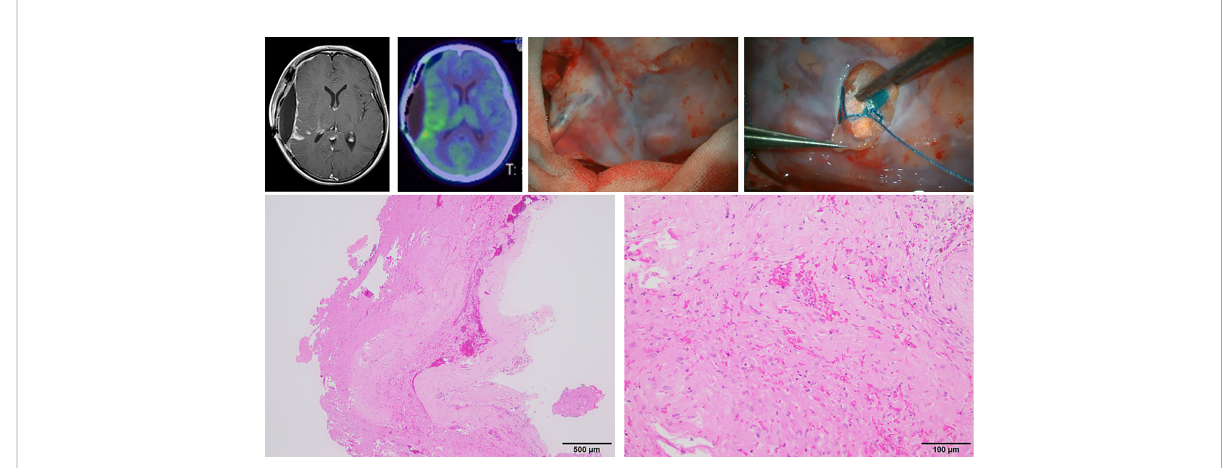
FIGURE 4 Microscopic view and histopathological fi ndings of a thick membranous tissue on the brain surface, which showed homogenous enhancement on gadolinium-enhanced magnetic resonance imaging on postoperative day 9 in case